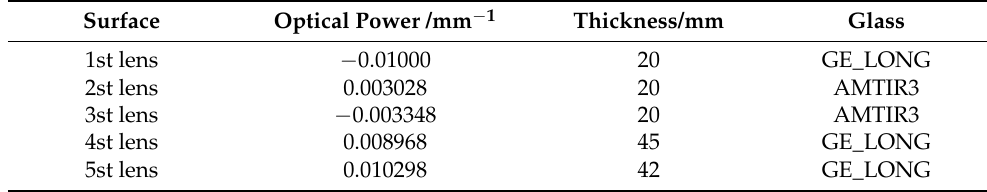
Figure 9. The rear-reflection path 2. ( a ) Optical layout diagram. ( b ) Spot diagram. ( c ) Distortion of the different wavelengths. ( d ) Field curvature of the different wavelengths. ( e ) Modulation transfer function diagram. Table 6. Initial parameters of longwave-infrared